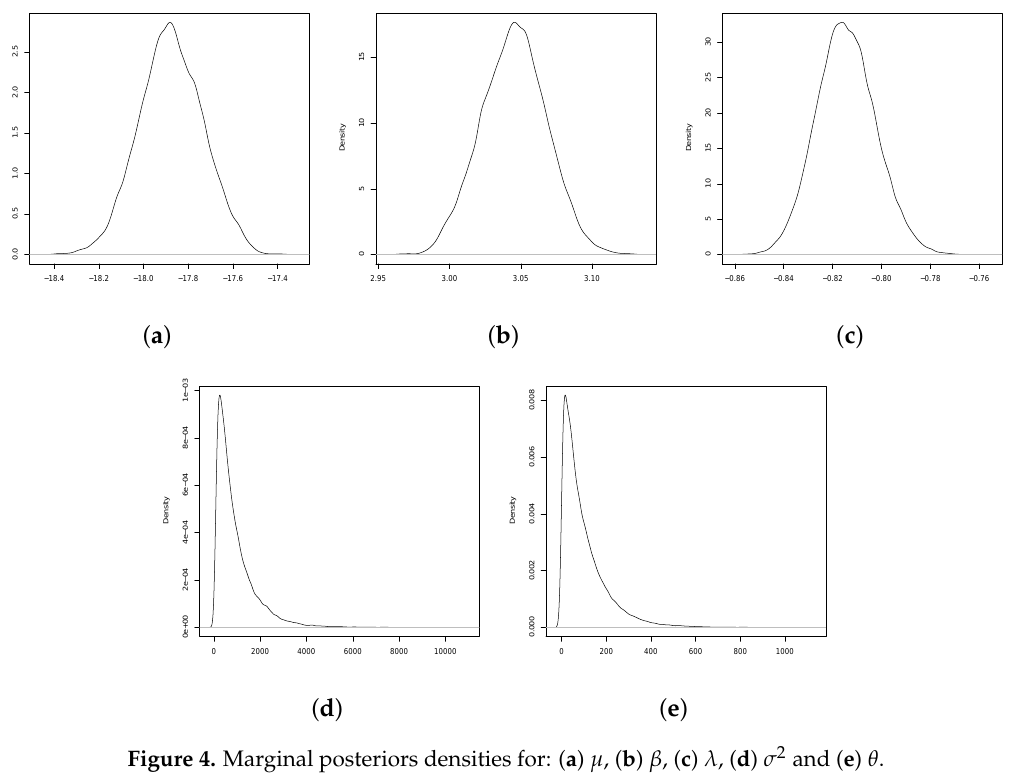
Figure 4. Marginal posteriors densities for: ( a ) µ , ( b ) β , ( c ) λ , ( d ) σ 2 and ( e ) θ .